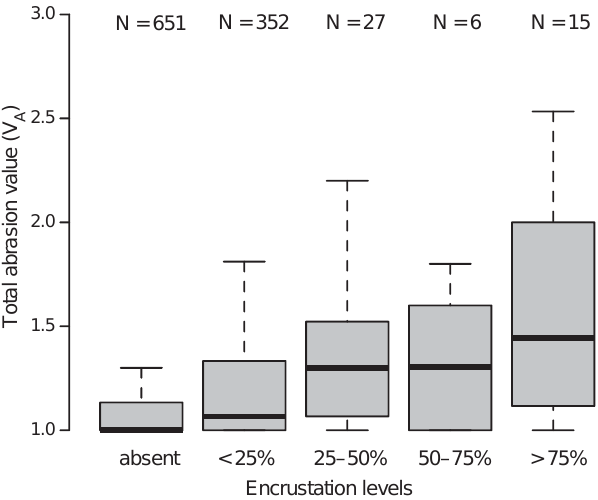
Fig. 4. Box-Whisker plot of the taphonomic value of Echinocyamus pu- sillus samples among the five encrustation levels. Outliers were removed from the graph. N, number of individuals.